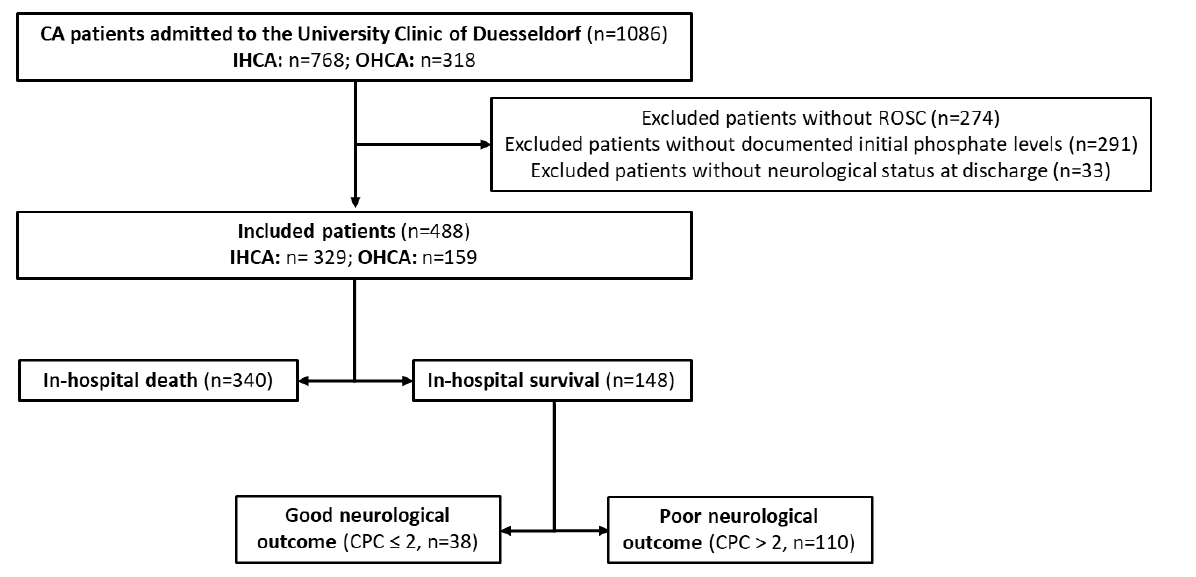
Figure 1. Flow chart of the CA patient ’ s population in our analysis.